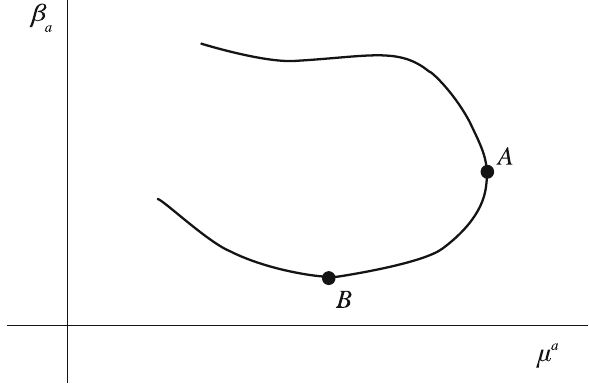
Fig. 5 Example of stability curves. A conjugate variable β a against a control parameter μ a is plotted. The point A is a turning point, where a stability change can occur. At point B a stability change does not occur even if the slope changes its sign